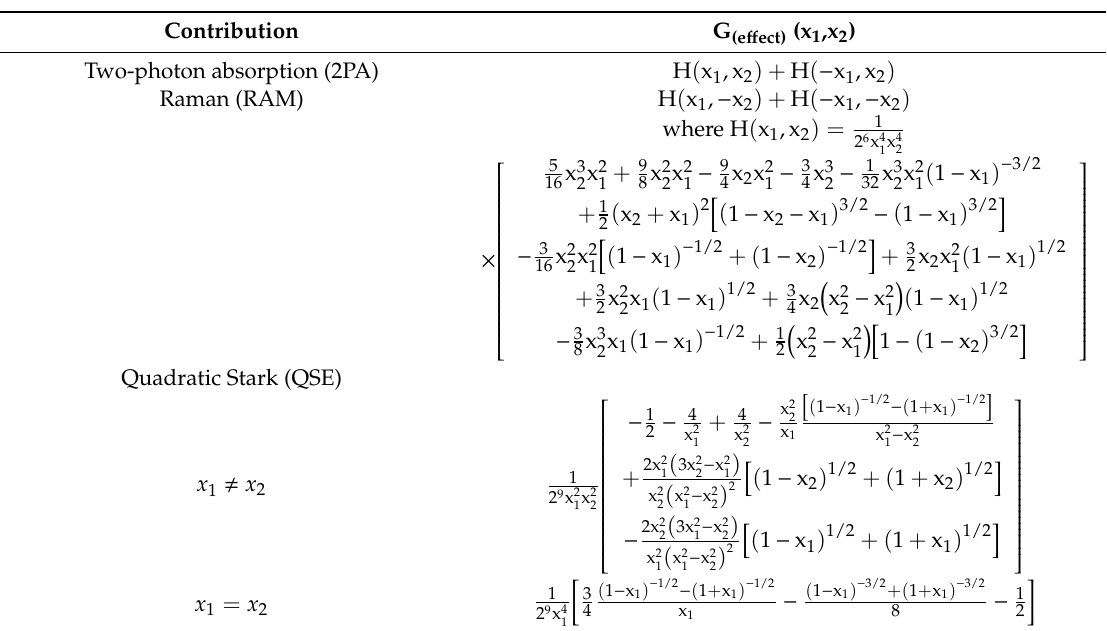
Table 1. Contribution from di ff erent e ff ects to the nondegenerate dispersion function G 2 (x 1 ,x 2 ) of the nonlinear refractive index